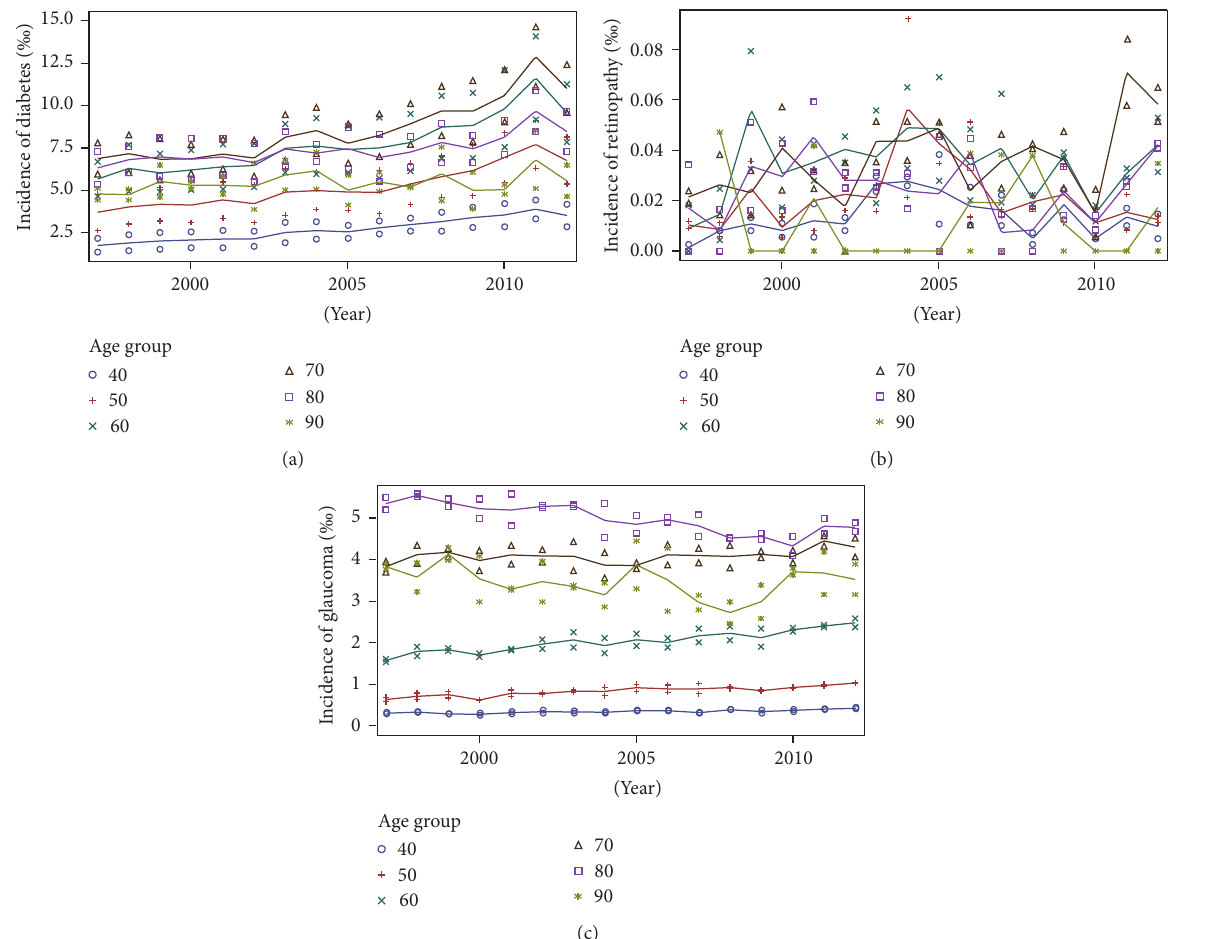
Figure 2: Incidence of diabetes mellitus, diabetic retinopathy, and glaucoma in the Danish population, in the period from 1996 to 2012, per 1000 individuals (‰). (a) Diabetes mellitus incidence. (b) Diabetic retinopathy incidence. (c) Glaucoma